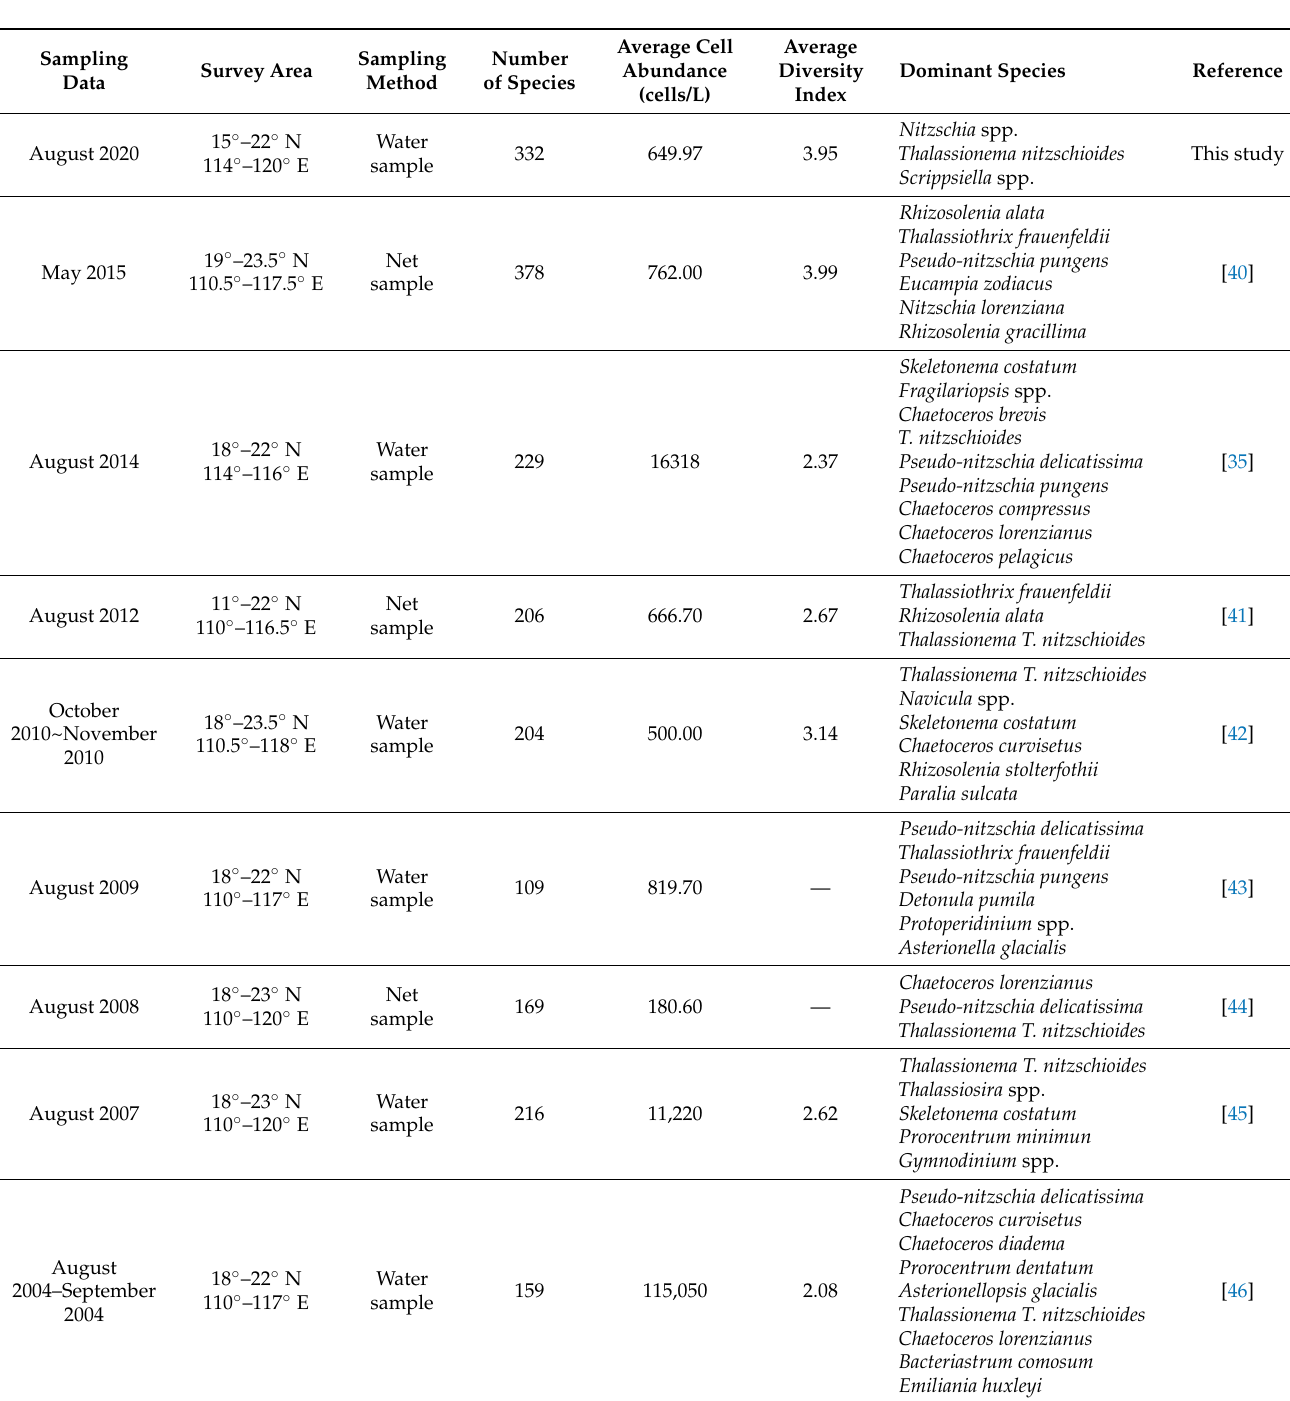
Table 1. Comparison of dominant phytoplankton species composition and historical data in the northern South China